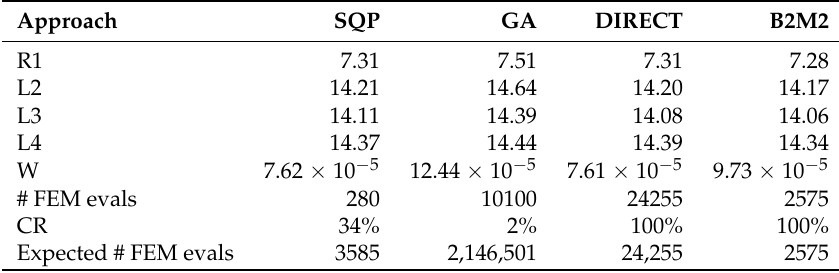
Table 2. TEAM Workshop problem 25 optimization